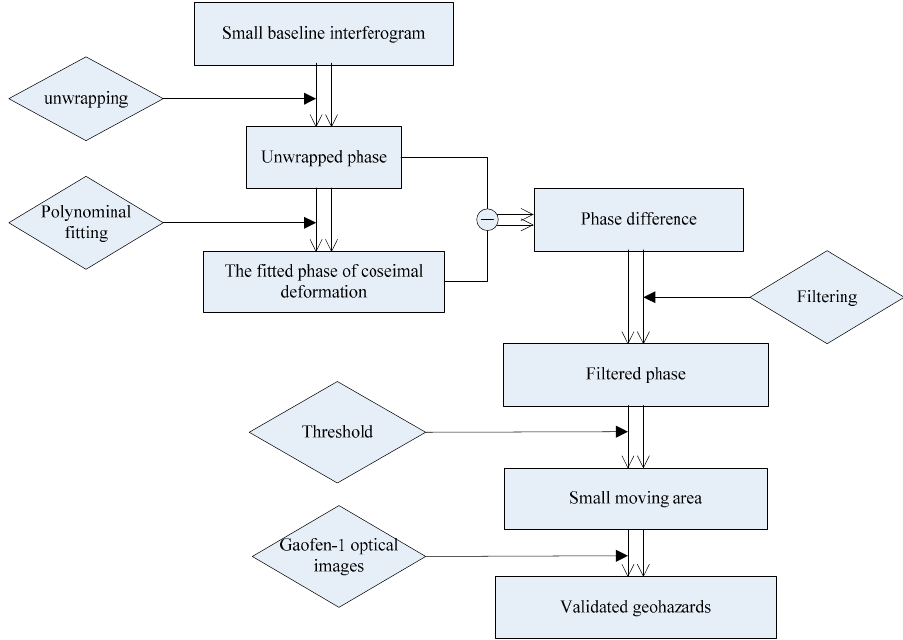
Figure 4. The flowchart of geo-hazard area detection based on a single differential interferogram.